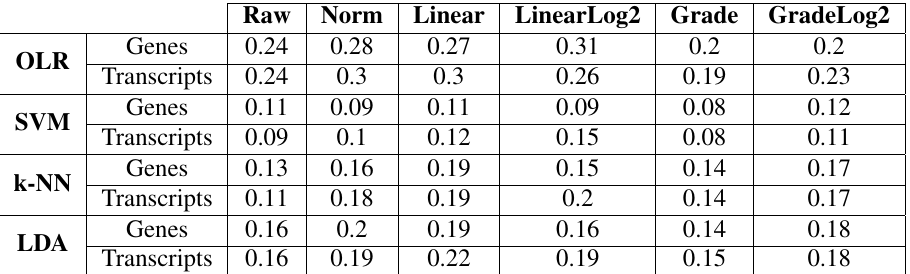
Table 7: LOOCV error rate for Affymetrix and Agilent integrated data Raw Norm